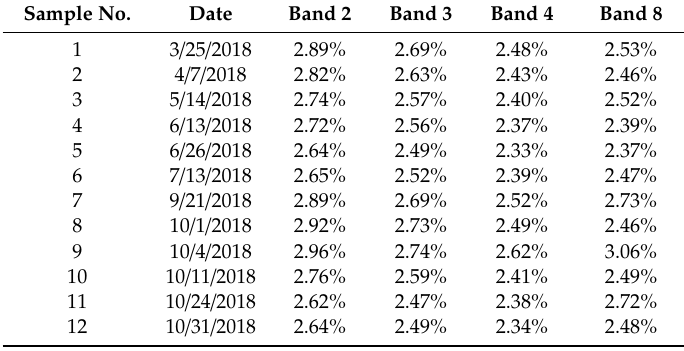
Table 2. The combined uncertainty results of total irradiance arriving at the ground in bands 2, 3, 4, and 8 of Sentinel-2B /